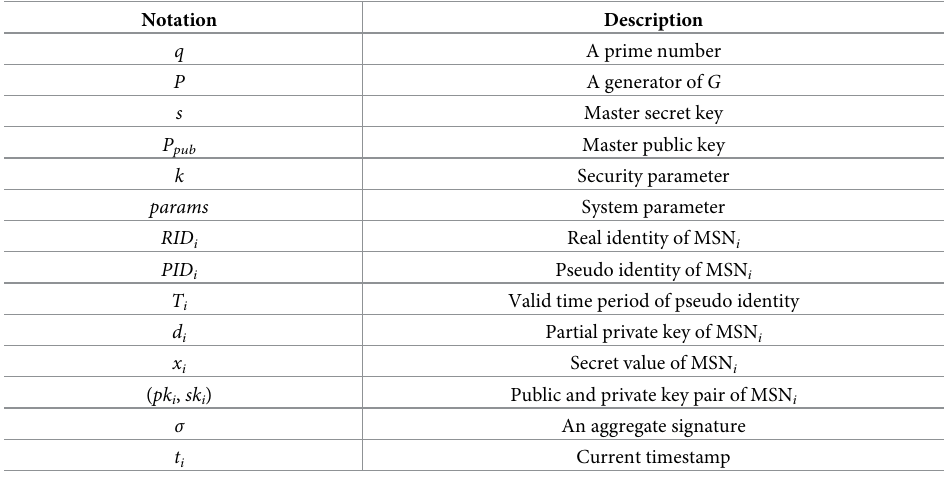
Table 1. Notations used in PF-CLAS